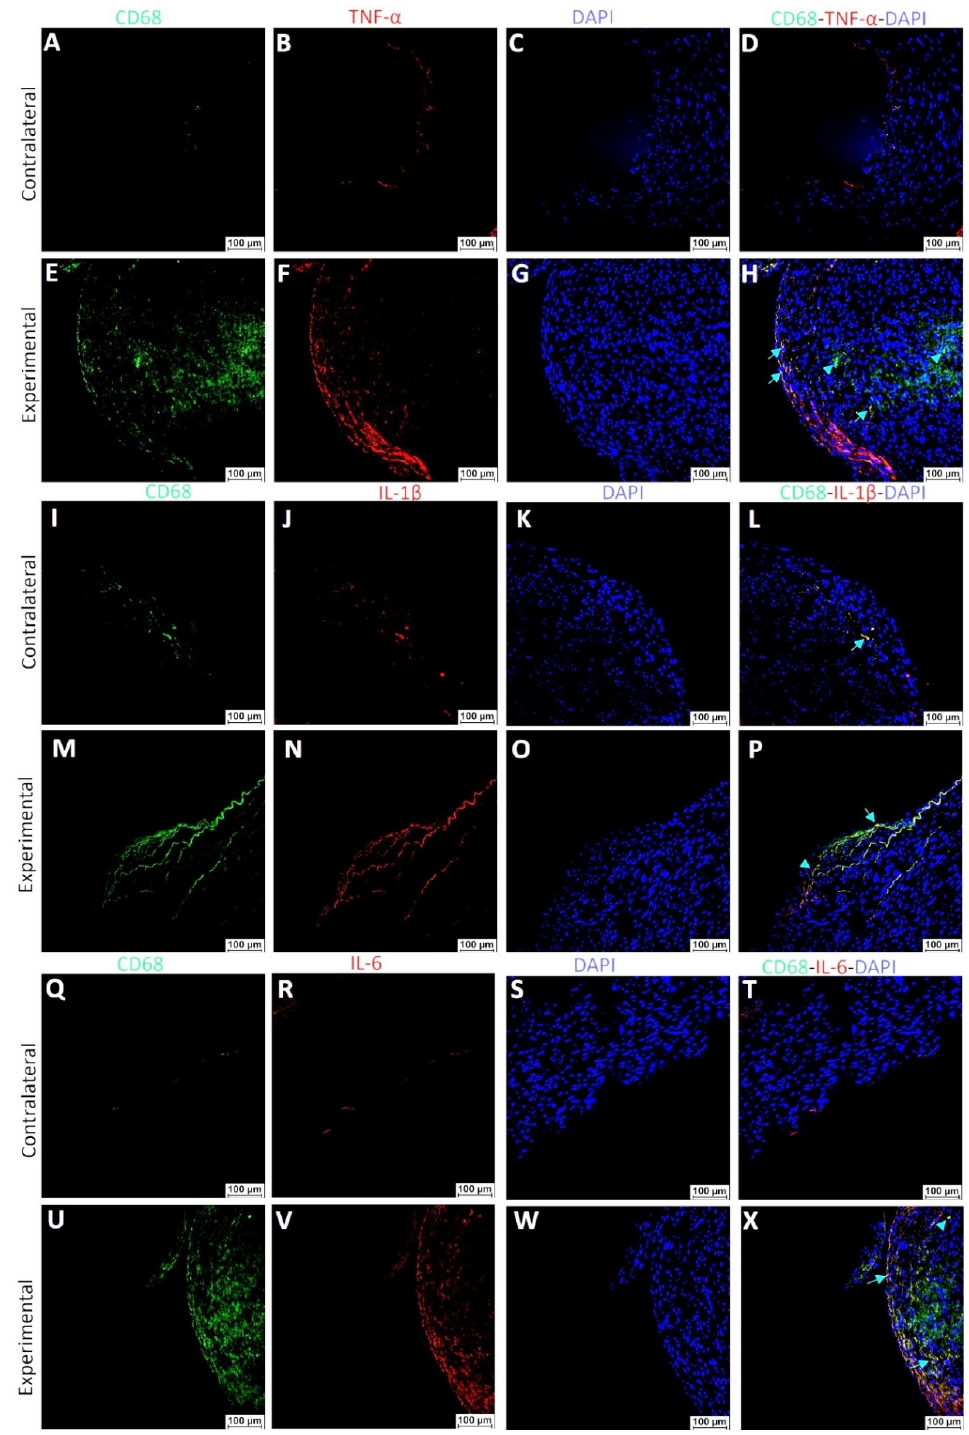
Figure 12. Dual ‐ immunofluorescence of control arteries (contralateral) and arteries with plaque (experimental) for CD68 and IL ‐ 6, IL ‐ 1 β , and TNF ‐α . Immunofluorescence for macrophage marker CD68 (panels A , E , I , M , Q , U ), tumor necrosis factor ‐ alpha (TNF ‐α , panels B , F ), interleukin 1 beta (IL ‐ 1 β , panels J , N ), interleukin 6 (IL ‐ 6, panels R , V ), 4 ′ ,6 ‐ diamidino ‐ 2 ‐ phenylindole (DAPI, panels C , G , K , O , S , W ) and merged images (panels D , H , L , P , T , X ). Control—arteries without plaque and experimental—arteries with plaque. The arrows indicate dual positive cells while the arrowhead indicates immunopositivity for one protein.